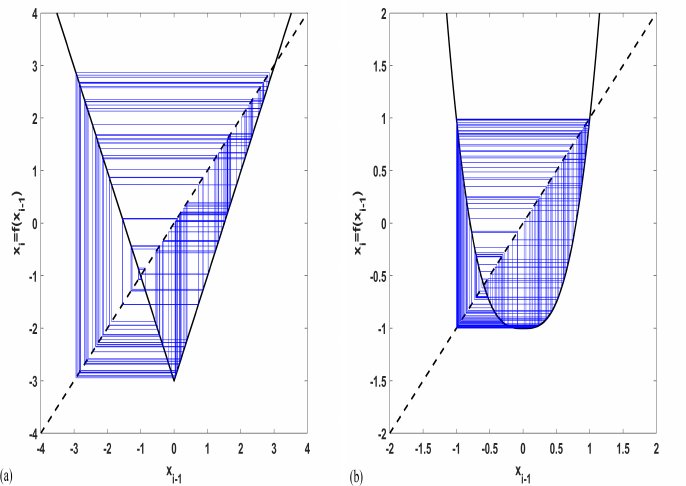
Figure 2. Cobweb diagrams of the map (1) for x 0 = 0.1 and: ( a ) r = 1, a = 3, b = 1.99; ( b ) r = 3, a = 1, b = 1.99.